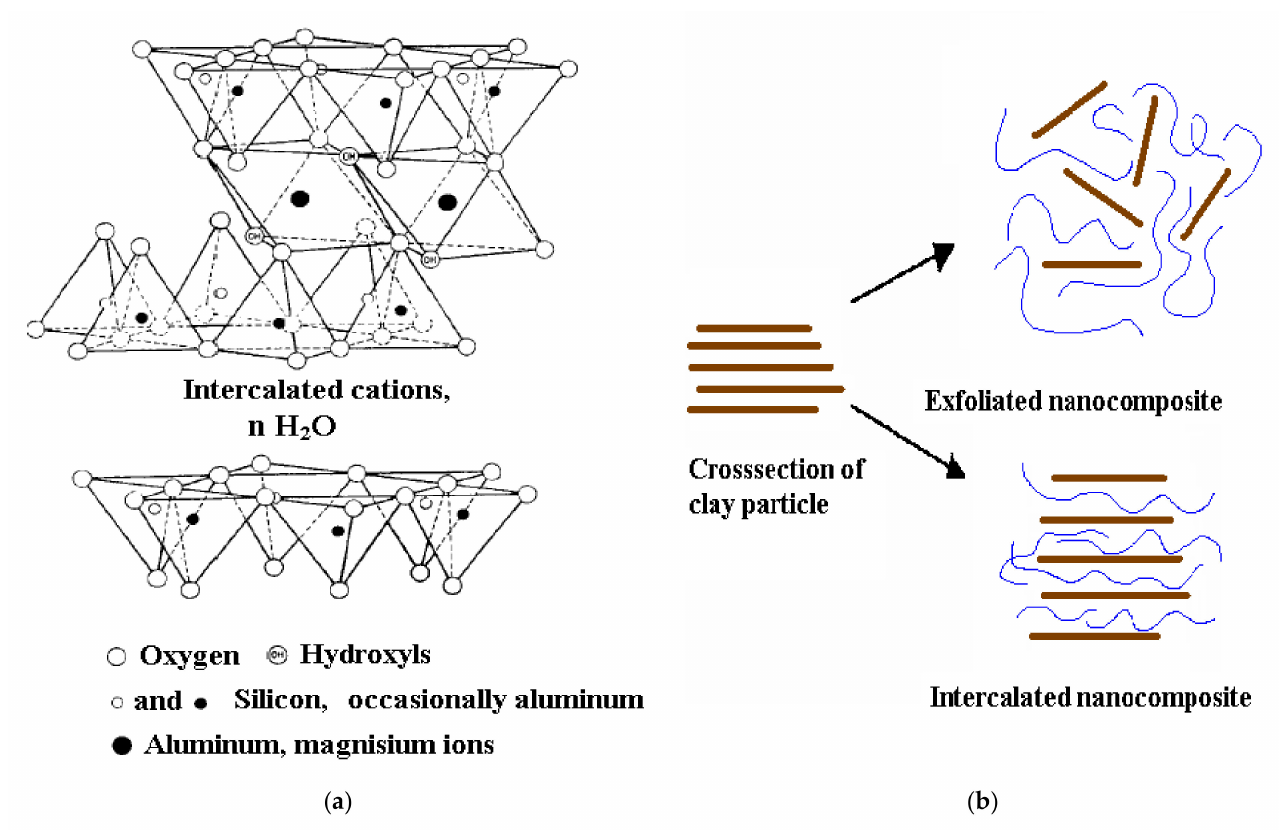
Figure 2. Crystallographic structure of the clay layer ( a ) and schematic view of nanocomposites formed with polymer ( b